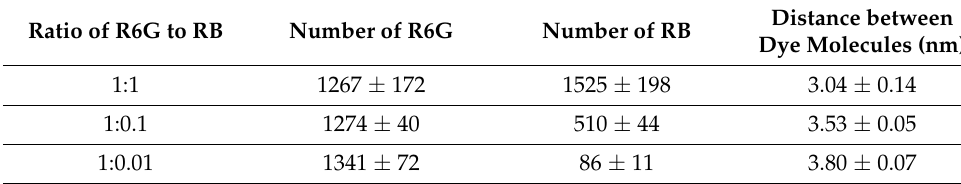
Table 1. Numbers of Dye Molecules in the Synthesized Nanoparticles. Ratio of R6G to RB Number of R6G Number of RB